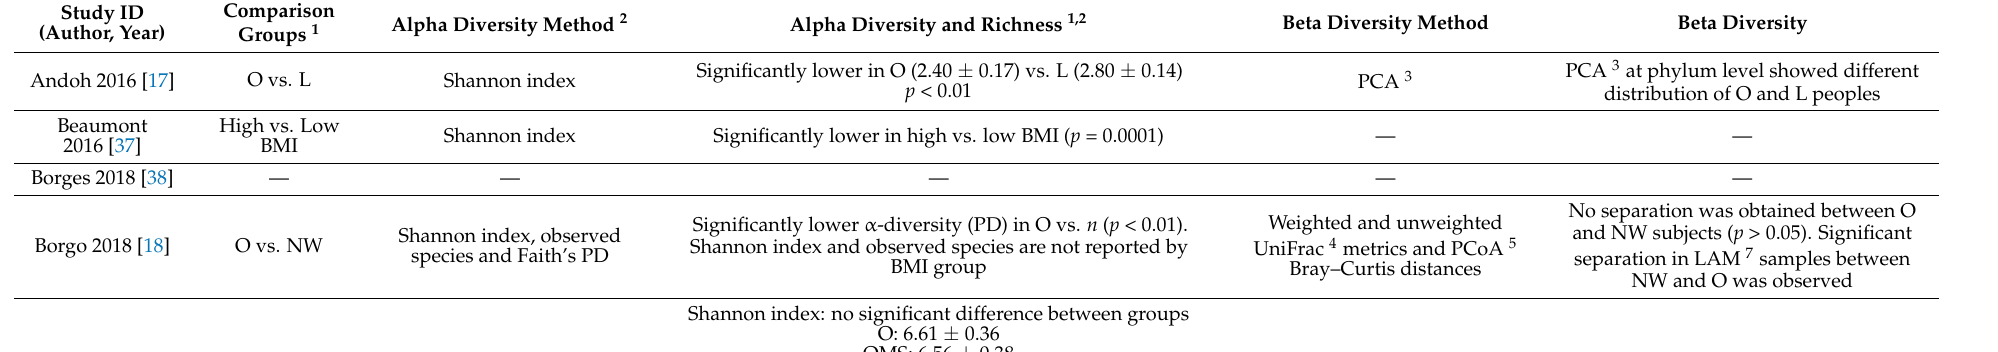
Table 2. Description of methods and results of microbial diversity and richness